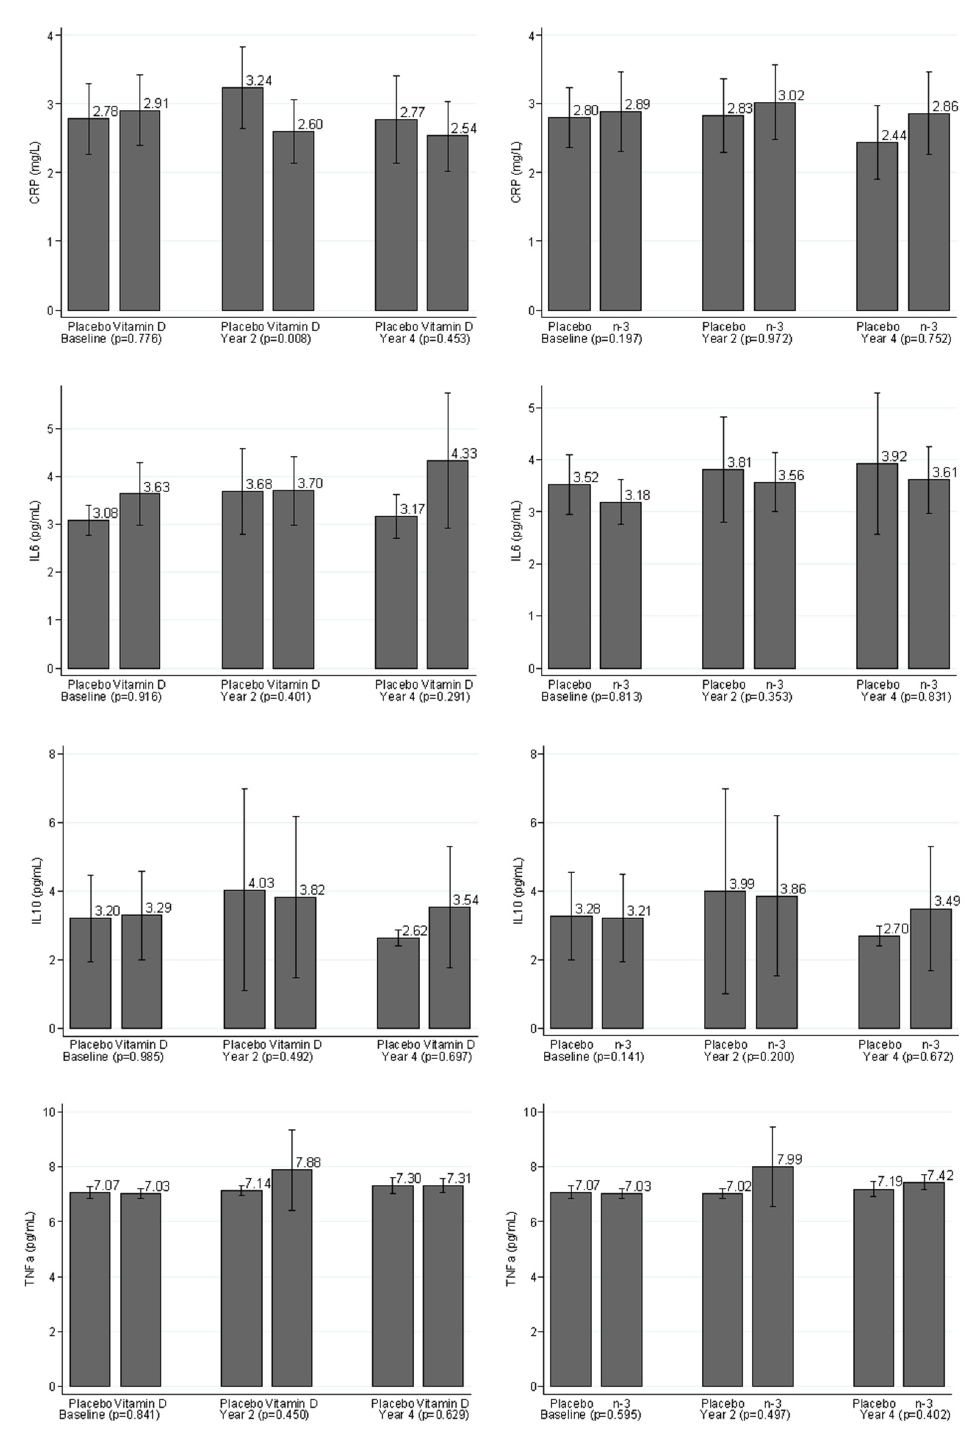
Figure 1. Bar charts of inflammatory markers grouped by vitamin D 3 and n -3 FAs assignments at baseline, year 2, and year 4. Inflammatory markers were compared between the placebo group and treatment group on each visit as of baseline, year 2, and year 4; p -values were calculated using Wilcoxon rank-sum test because of the non-normal distribution of the inflammatory